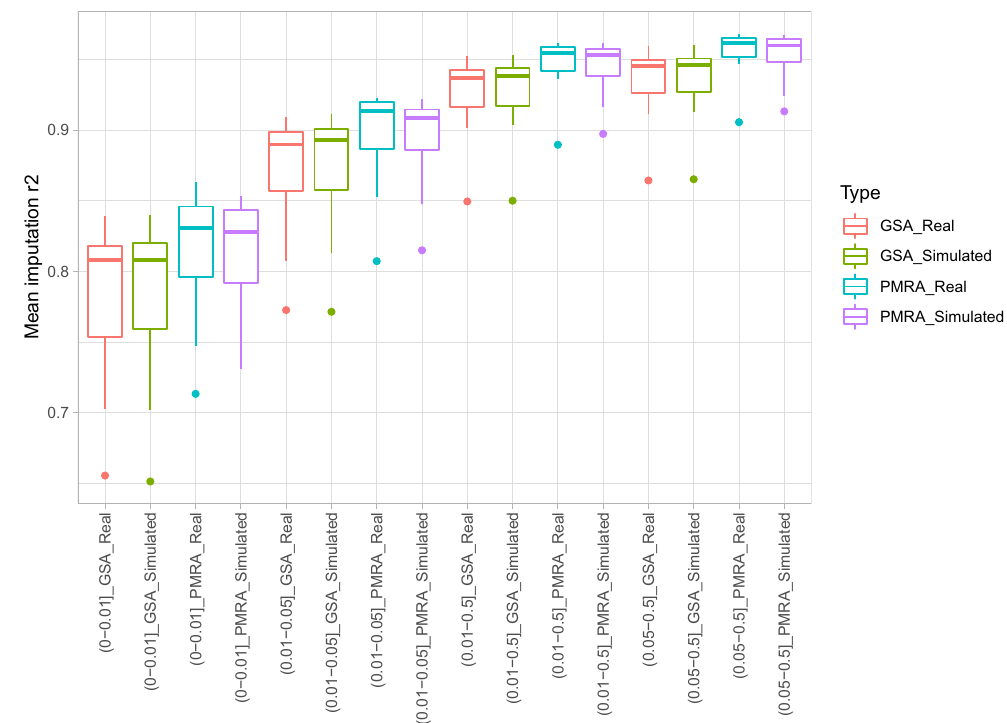
Figure 5. Mean imputation accuracy comparisons of simulated and real data of the Axiom Precision Medicine Research Array (PMRA) and the Infinium Global Screening Array v3.0 (GSA) genotyped of 24 VNP samples at various MAF bins measured in 22 autosomes.